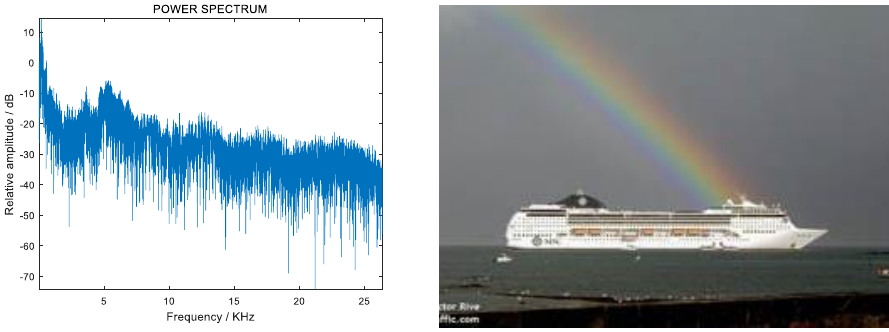
Figure 2. Radiated noise power spectrum ( left ) and picture ( right ) of an ocean liner.